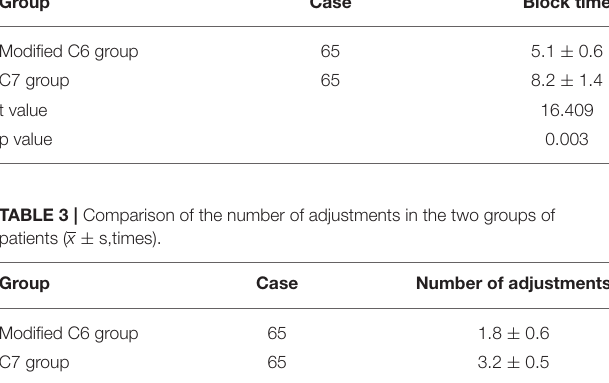
spondylosis: headache: dysmenorrhea